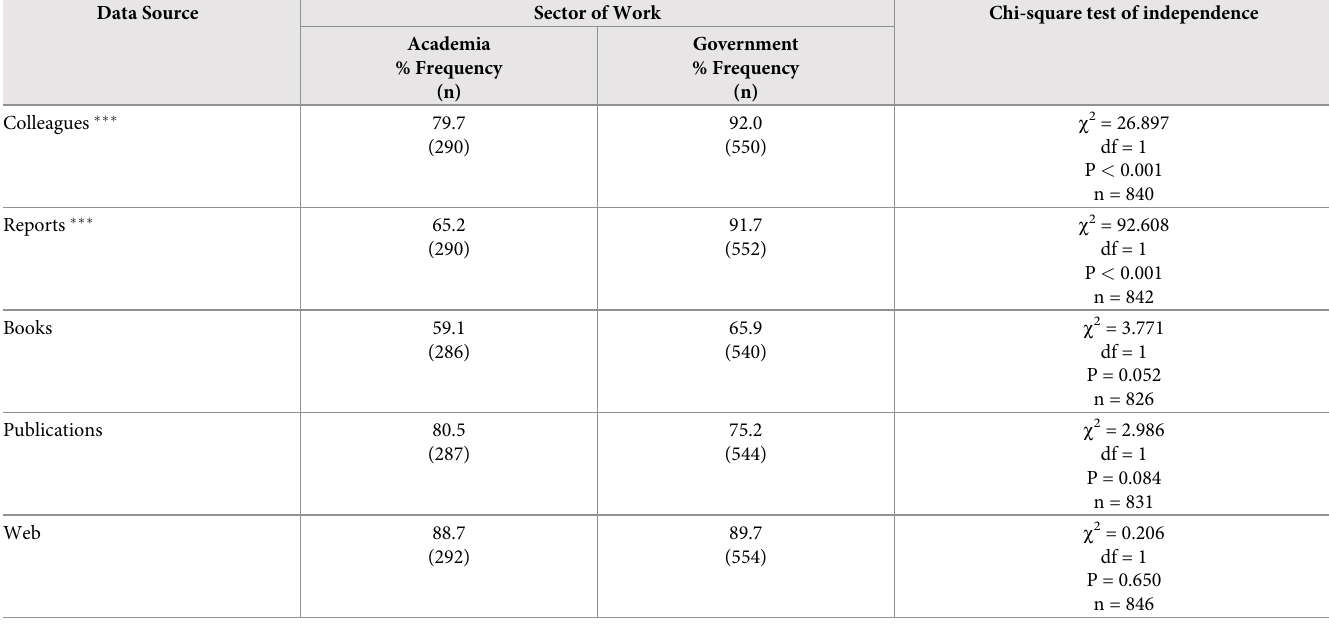
Table 8. Frequency of use of sources of species occurrence